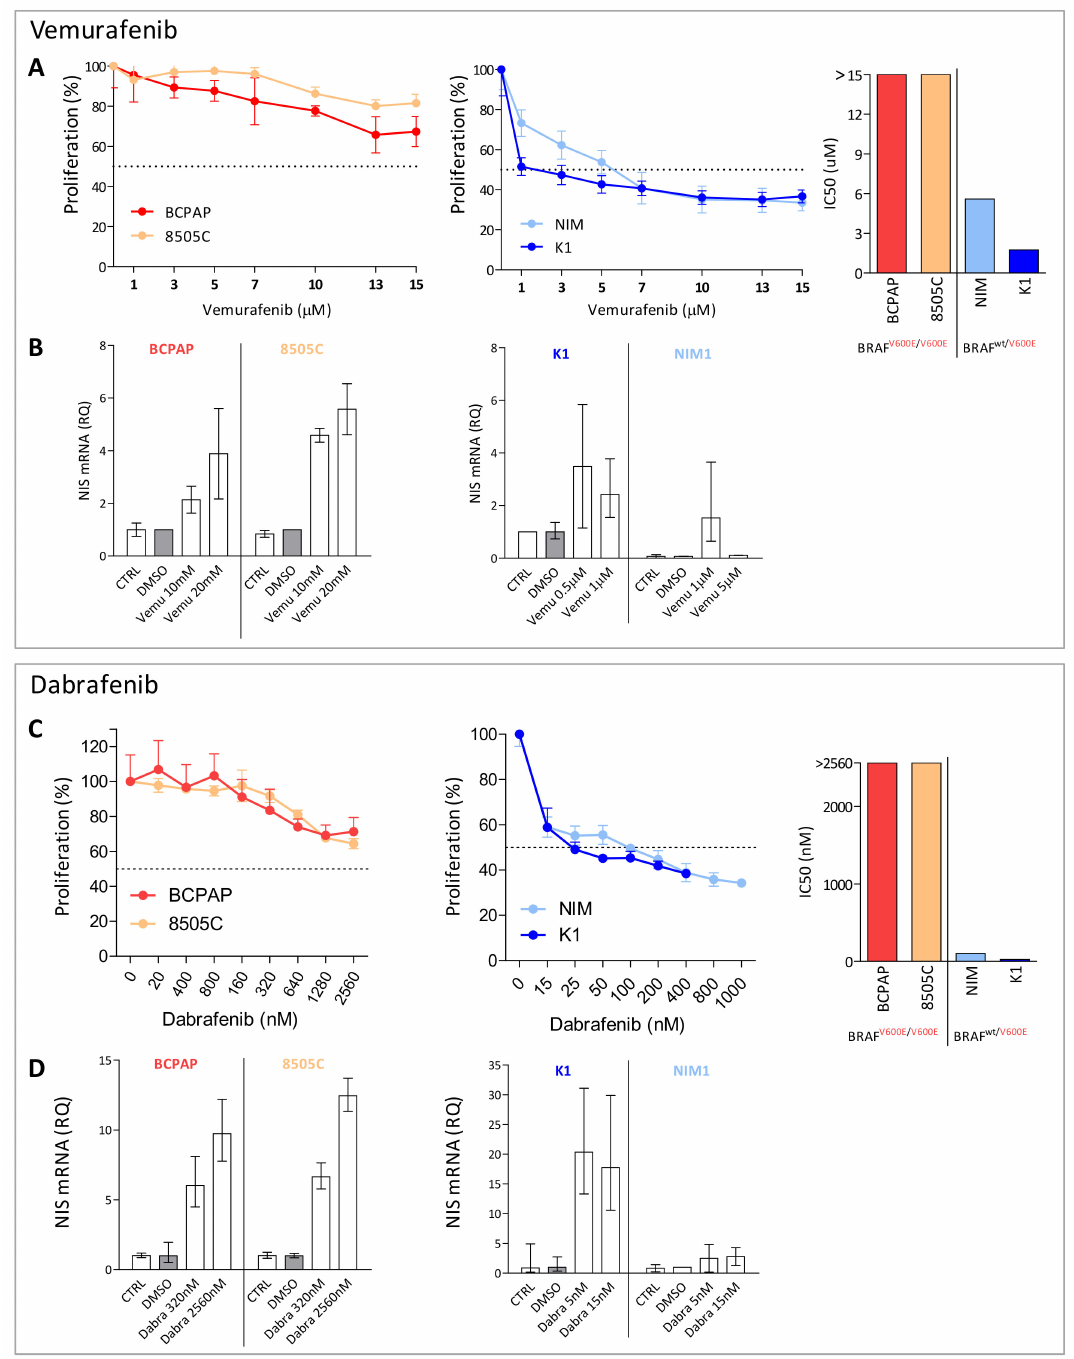
Figure 2. BRAF inhibitors treatment in BRAF V600E mutated thyroid cancer cell lines. ( A , C ) Dose-response curves in thyroid cancer cell lines (BCPAP, 8505C, K1, NIM1) treated for 48 h with increasing doses of Vemurafenib or Dabrafenib. Cell proliferation was tested by crystal violet assay; data are reported as percentage normalized to control cells treated with vehicle DMSO, mean ± SD of six technical replicates. On the right, the corresponding IC50 values in the same cell lines stratified for BRAF V600E mutation status. ( B , D ) NIS expression by quantitative RT-PCR 48 h after Vemurafenib or Dabrafenib treatment; data are reported as relative quantity normalized to HPRT gene used as endogenous control and are shown relative to the control cells treated with DMSO. Mean ± SEM of three technical replicates. Abbreviations: CTRL, untreated control cells; DMSO, DMSO treated control cells; Vemu, Vemurafenib; Dabra,